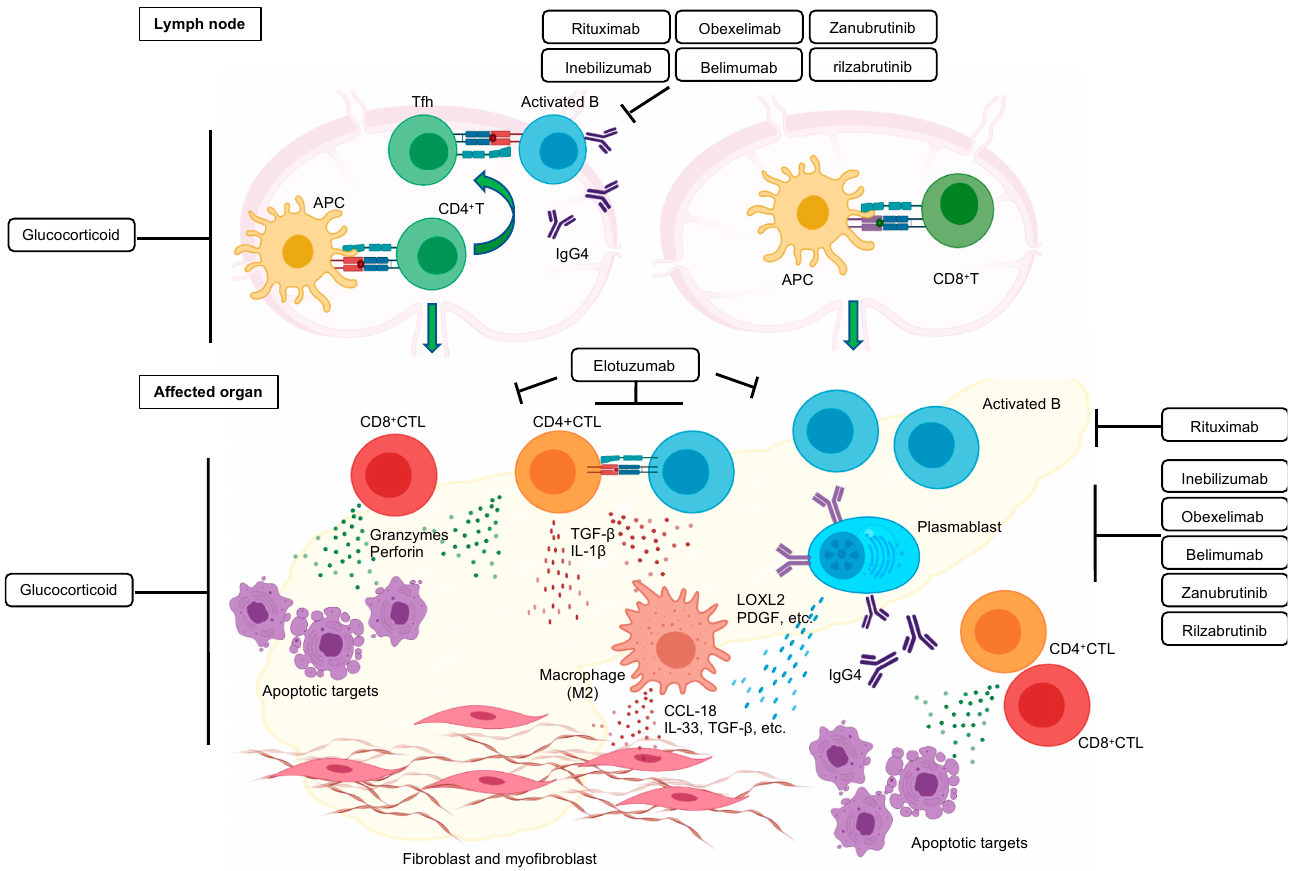
Figure 3. Schematic model of the pathogenesis and fibrosis of IgG4-RD. Self-antigen presented by MHC-class II on antigen presenting cells (APC) activates naïve B cells and CD4 + T cells in lymph nodes. Some CD4 + T cells differentiate into Tfh cells and collaborate with B cells to drive IgG4 class switching, somatic hypermutation, and plasmablast differentiation of antigen-detecting B cells. Activated B cells and CD4 + T cells then traffic to the target organ. In the affected organ, activated B cells help previously activated CD4 + T cells to differentiate into CD4 + CTLs, inducing cell apoptosis (possibly mesenchymal cells) with CD8 + CTLs, which are activated by self-peptide presented by MHC-class Ⅰ on APC in lymph nodes. The subsequent remodeling orchestrated by proteins secreted by T cells, B cells, and macrophages leads to fibrosis. Current and potential therapeutic drugs and their target cells are shown. These drugs act primarily on B cells and may inhibit fibrotic processes.